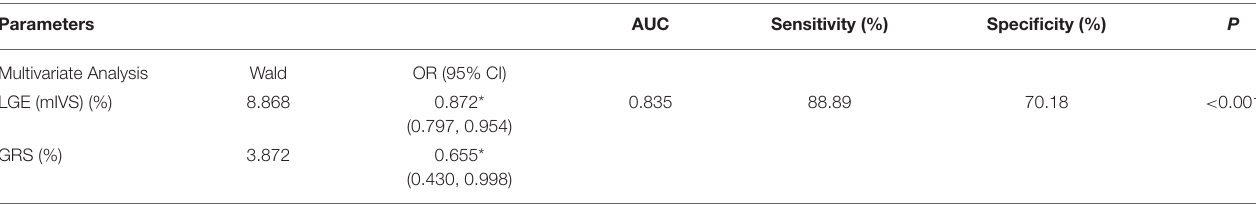
TABLE 5 | The multivariate logistic regression analysis of CMR parameters for discrimination of patients with HCM and HHD. Parameters Multivariate